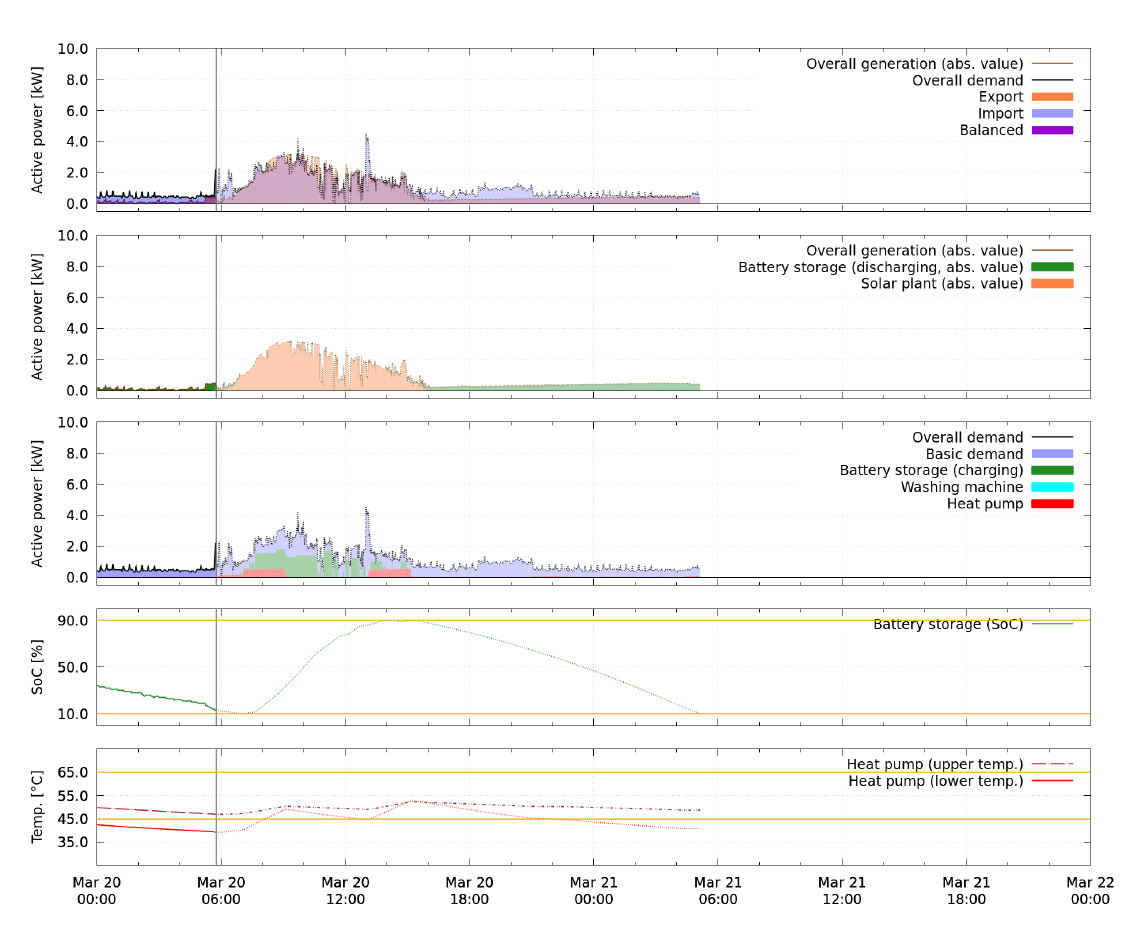
Figure 14. Experimental results from the demonstration site for 20 March: measured history until approximately 6:00 and planned schedules for the following 24